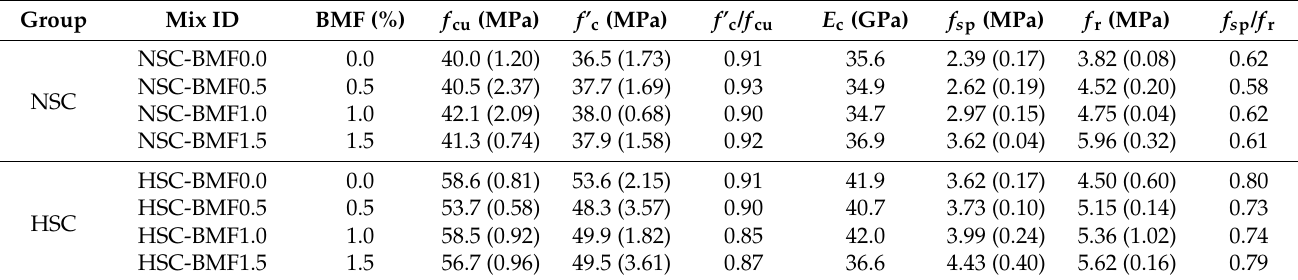
Values between parentheses represent the standard